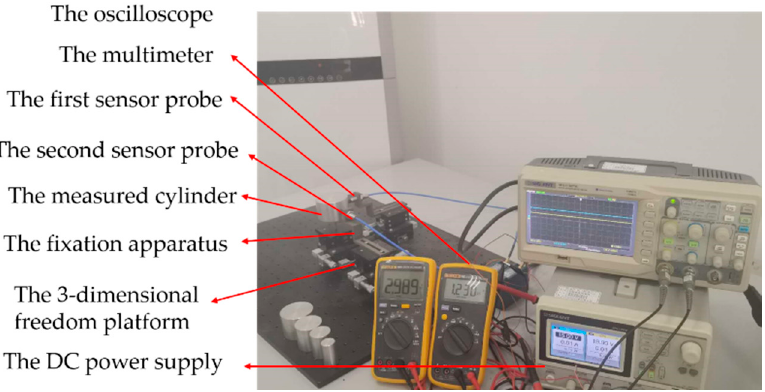
Figure 33. The orthogonal structure eccentric experimental platform.